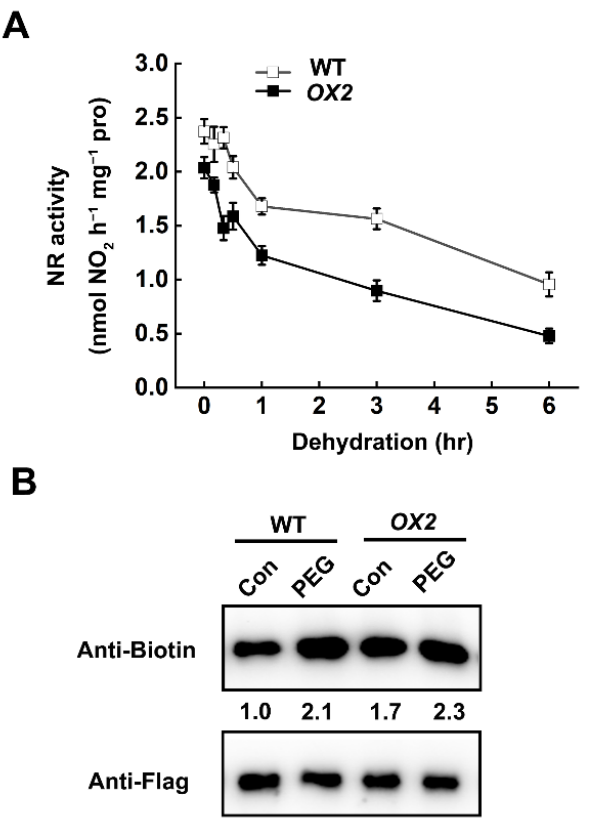
Figure 7. Overexpression of OsLCD1 enhances persulfidation and the activity decrease in NR. ( A ) Dehydration-inhibited NR activity. The 14-day-old wild-type (cv. Wuyunjing 7, WT) and OX2 rice seedlings were cultured under normal conditions. For the dehydration time-course experiment, leaf blade branches were isolated from cultivated soil and placed in filter paper. The leaves samples were harvested, and the total NR activity was measured at indicated time points. Data are means ± SD ( n = 3). ( B ) Wild-type and OX2 rice protoplasts with transiently expressed NIA2-Flag were treated with or without 100 µ M NaHS in the absence or presence of 10% PEG6000 1 h, and then the total proteins were extracted and analyzed by immunoblotting with an anti-Biotin and anti-Flag antibody. To further investigate the molecular mechanism of NIA2 in response to drought stress, the expression profiles of genes involved in drought stress response in the nia2 mutant were determined. RT-qPCR results showed that the transcript of genes encoding antioxidant enzymes, including APX2 and CATA , were significantly higher in nia2 mutant as compared to wild-type plants upon drought stress (Figure 8D,E). Meanwhile, after drought stress, the induction of bZIP23 and DREB genes in nia2 mutants was further enhanced compared with the wild type (Figure 8F,G). Based on these findings, we concluded that NIA2 negatively regulates rice drought